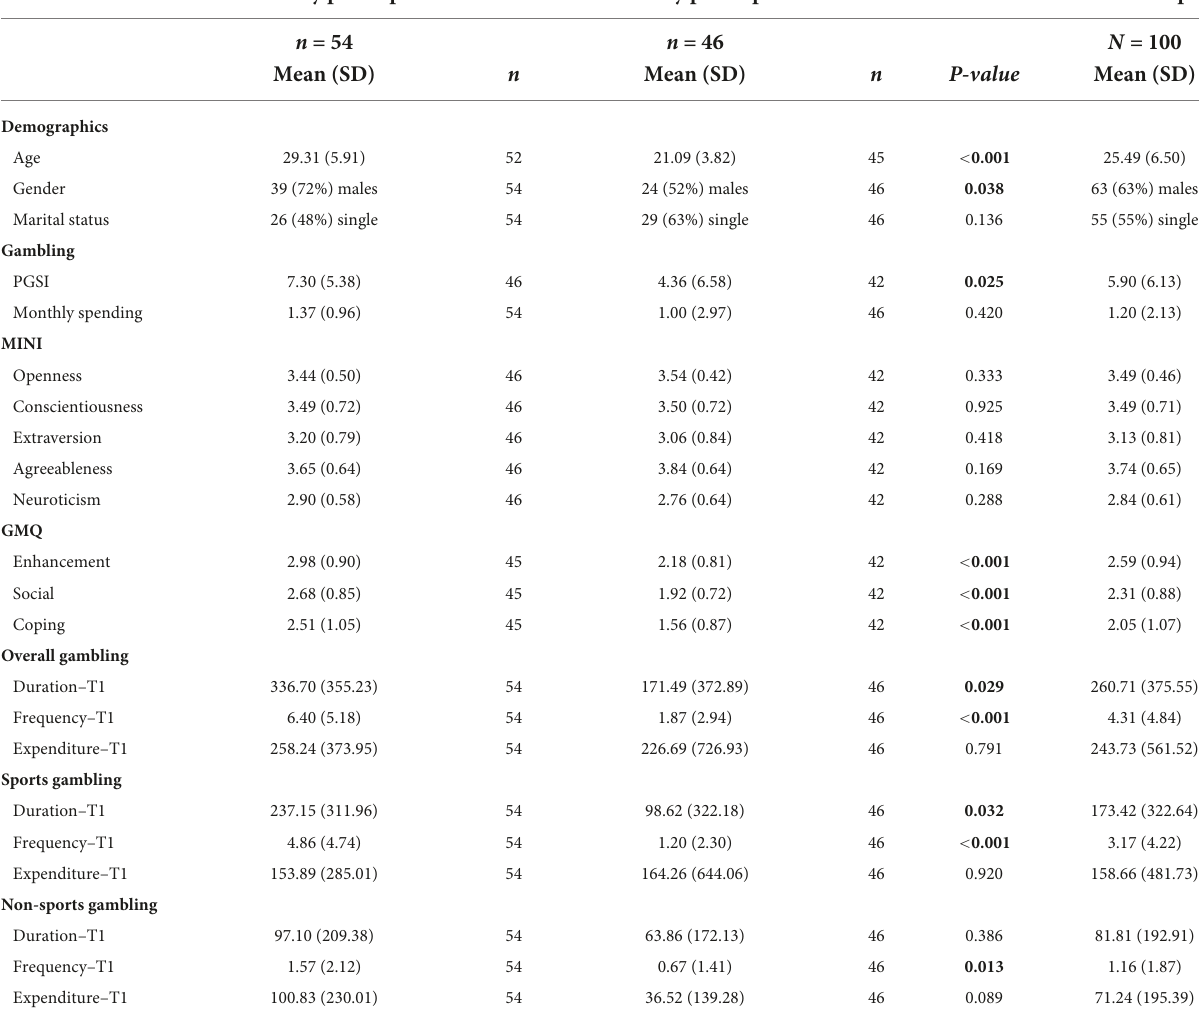
TABLE 1 Demographics of community and university-recruited participants.